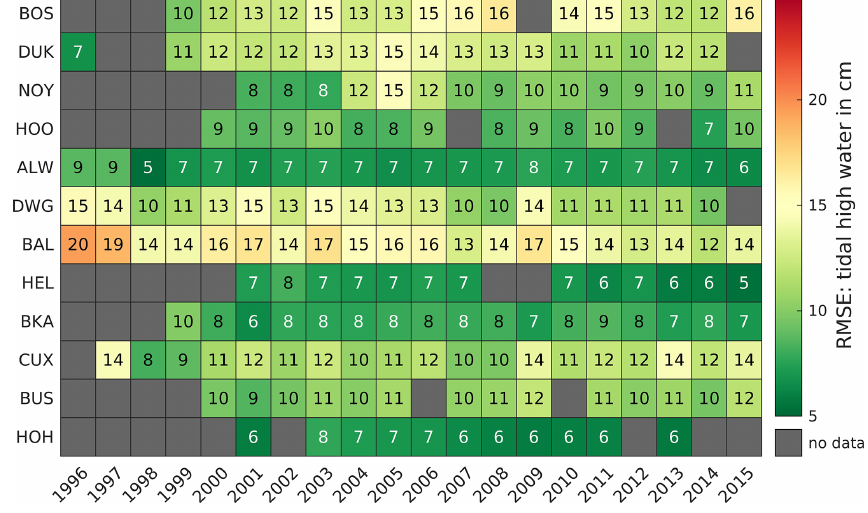
Figure 11. Root mean square error (RMSE) of the tidal high water in centimeters between 1996 and 2015 at representative